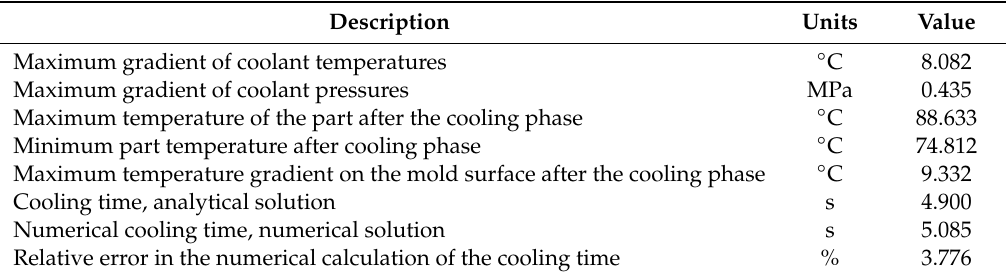
Table 12. Numerical results obtained for Case D cooling